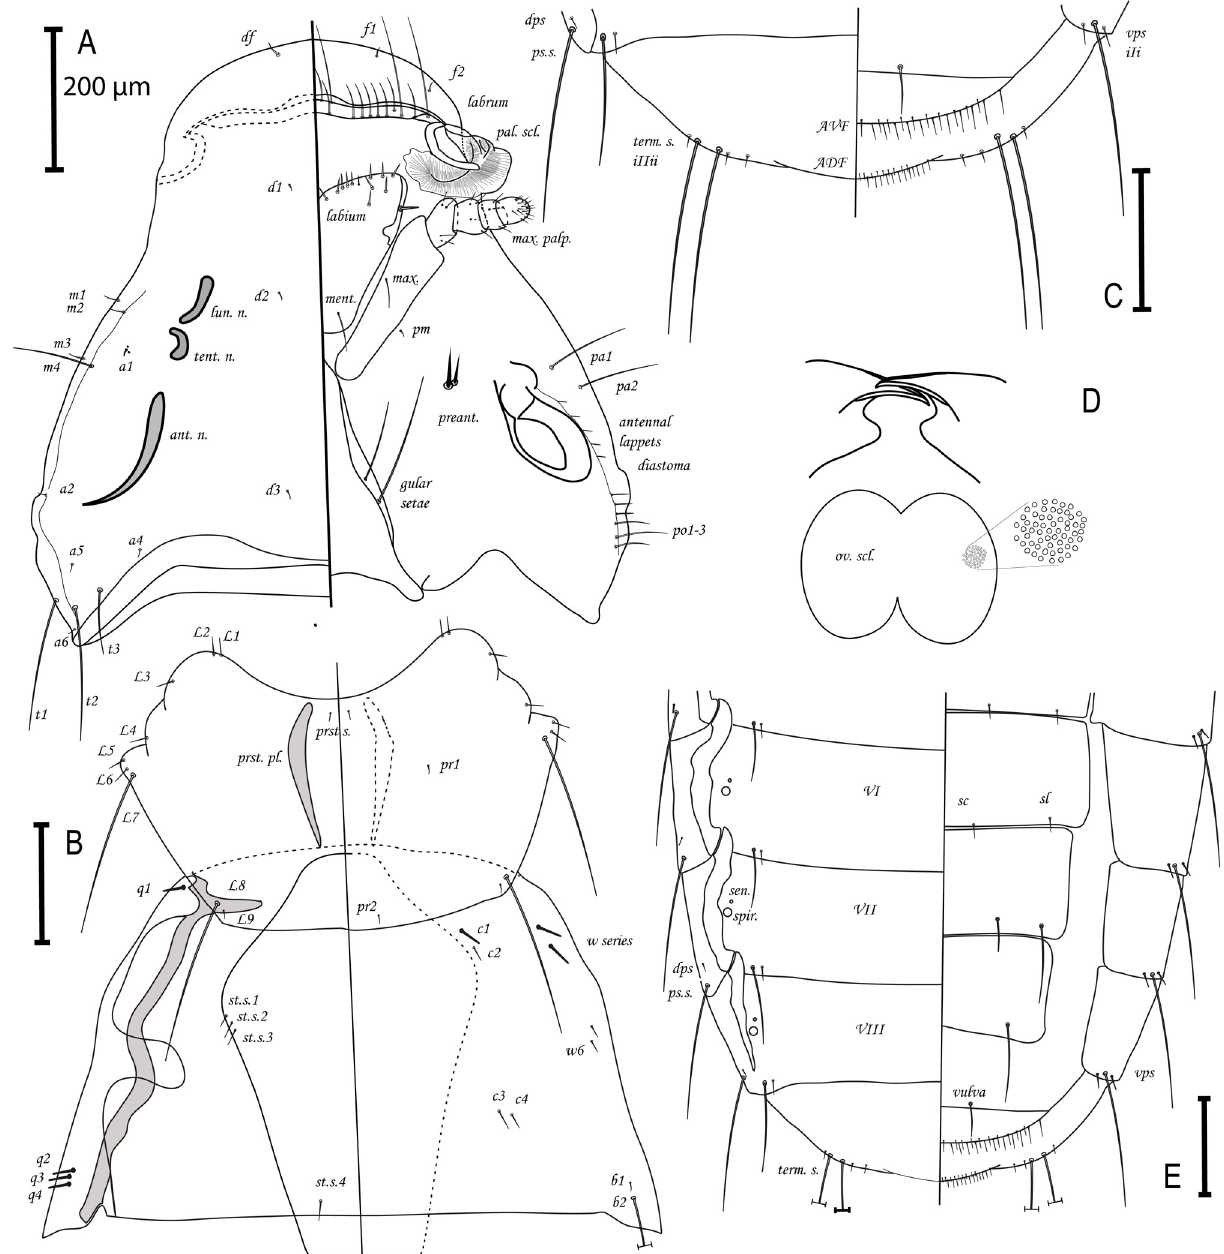
Figure 2. Ricinus vaderi n. sp. $ from Melanocorypha calandra . (A) Head, dorsoventral view: df , dorsal setae of the frons; f , ventral setae on the frons; a , setae on the temples dorsally; d , setae on the dorsum of the head; t , setae positioned dorsolaterally on temples; m , setae dorsoventrally on the marginal carinae; po , postocular setae; pa , paraantennal setae; preant ., preantennal setae; ment. , mental setae; pm , paramental setae; max. palp. , maxillary palpi; max. , maxillary setae; pal. scl. , pallete sclerite; lun. n. , lunar nodi; tent. n. , tentorial nodi; ant. n. , antennal nodi. (B) Thorax, ventrodorsal view: L , lateral prothoracic setae; pr , dorsal prothoracic setae; prst. pl. , prosternal plate; prst. s. , prosternal plate setae; q , setae ventrally and submarginally on the pterothorax; st. s. , sternal setae; c , four pairs of setae dorsally on the pterothorax; w , series of lateral setae on the pterothorax; b , dorsal setae on the posterior margin. (C) Abdomen terminus. term. s. , terminal setae of tergite IX; vps , ventral pleural setae; I , long pilose seta; i , short pilose seta; S , large spine; s , small spine (spines are on pleurites II–IV); ADF , dorsal anal fringe; AVF , ventral anal fringe. (D) Mandibles and ornamented ovoid sclerite of the nymph: ov. scl. , ovoid sclerite. (E) Abdomen, dorsoventral: sen. , sensilla; spir. , spiracle; dps , dorsal pleural setae; ps.s. , postspiracular setae; VI–VIII , tergites; sc , sternal central setae; sl , sternal lateral setae. Scale bar is 0.2 mm for all